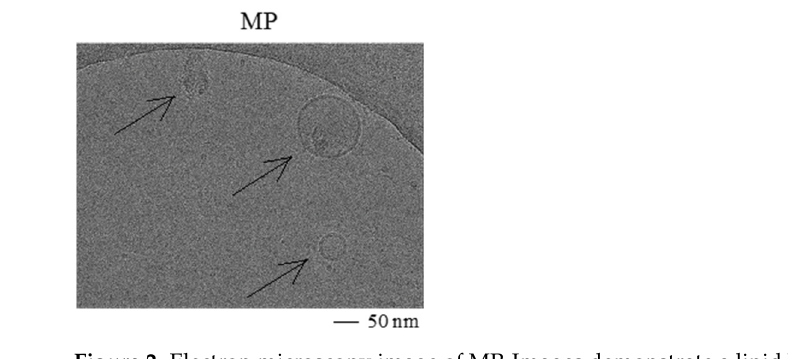
Figure 2. Electron microscopy image of MP. Images demonstrate a lipid bilayer in MP. Table 1. MSC donor characteristics. Characteristics of MSC donor age, gender, MSC passage number and number of EV and MP isolated per MSC. Donor